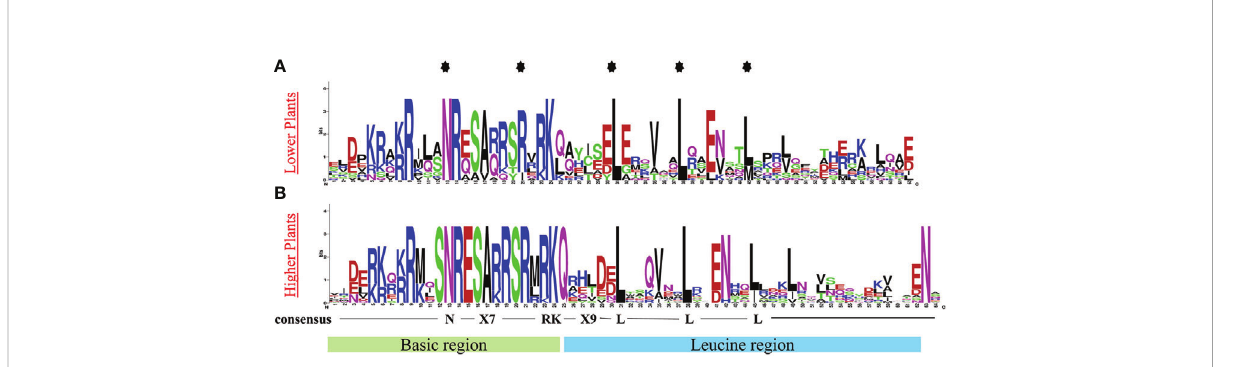
FIGURE 1 Conserved bZIP domain logo in (A) Lower plants, using protein sequence representatives from: C. reinhardtii and P. patens , (B) Higher plants, using protein sequence representatives from 5 land plants. The logo depicts the basic region (motif 2-20) and the leucine zipper region (motif 20-35). The logo was generated using online WebLogo tool